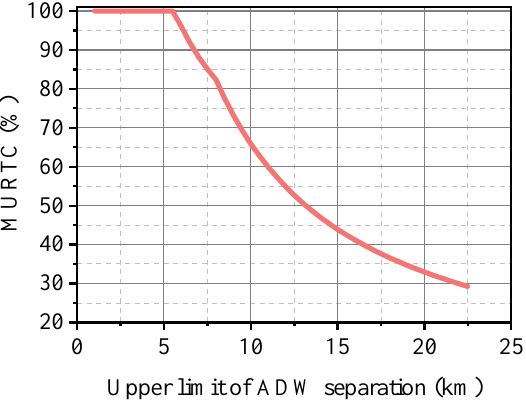
Figure 16. Relationship between ADW separation and maximum utilization of runway theoretical capacity